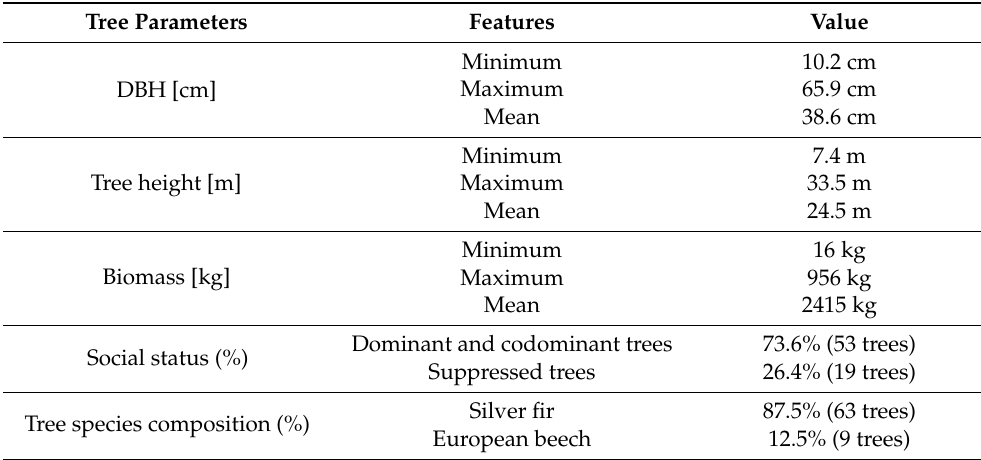
Table A1. The parameters of the trees located in the study area (Dinaric Mountains, Southwest